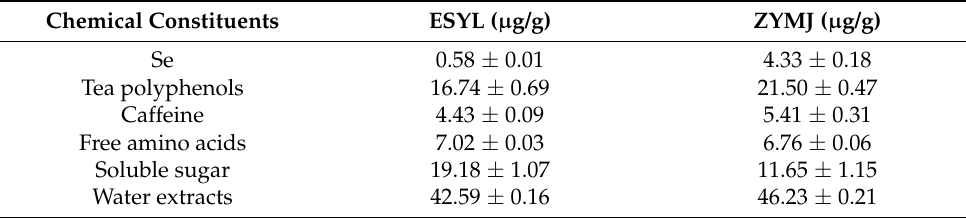
Table 1. Comparison of the main components of ESYL and ZYMJ ( µ